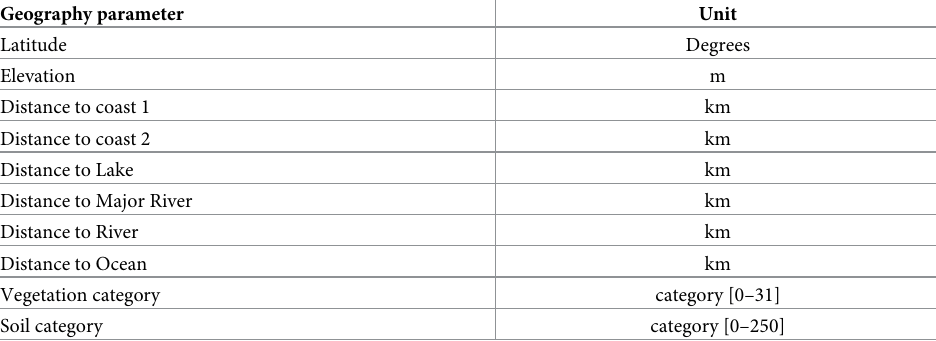
Table 2. Geography parameters. Aside from latitude and elevation (the latter has been taken from the ERA-Interim reanalysis), the other variables are from the G-Econ